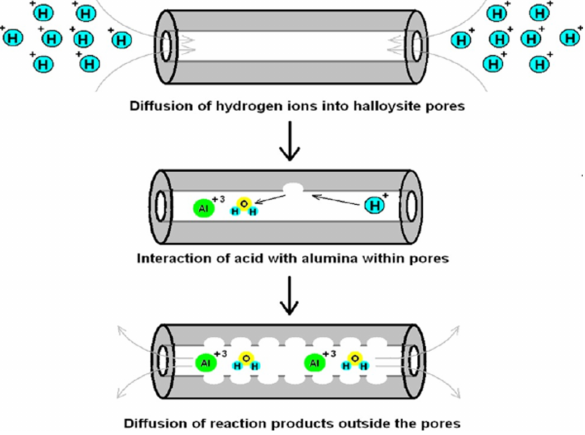
Figure 4: Acid etching of alumina inner layers from halloysite lumen demonstrated by Lvov et al.